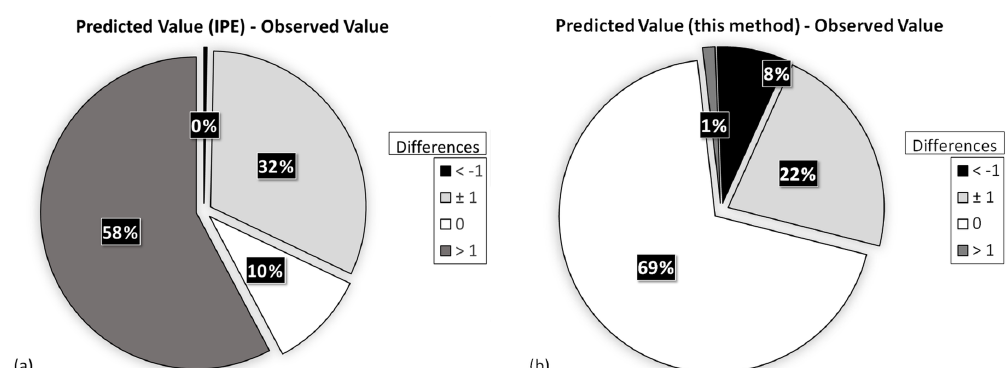
Figure 6. Differences between the observed intensity values, as reported in DBMI15 (Galli and Camassi, 2009), for the 2009 L’Aquila earthquake and the intensity values computed with (a) the IPE alone (Pasolini et al., 2008; Lolli et al., 2019) and (b) the proposed procedure.